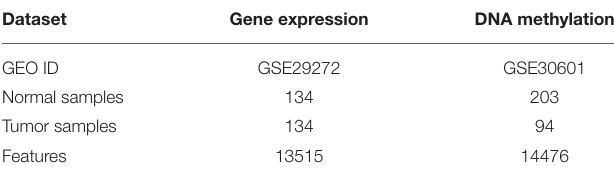
TABLE 3 | Performance comparison on different metrics (the accuracy, precision, recall, F1-score, and AUC value are